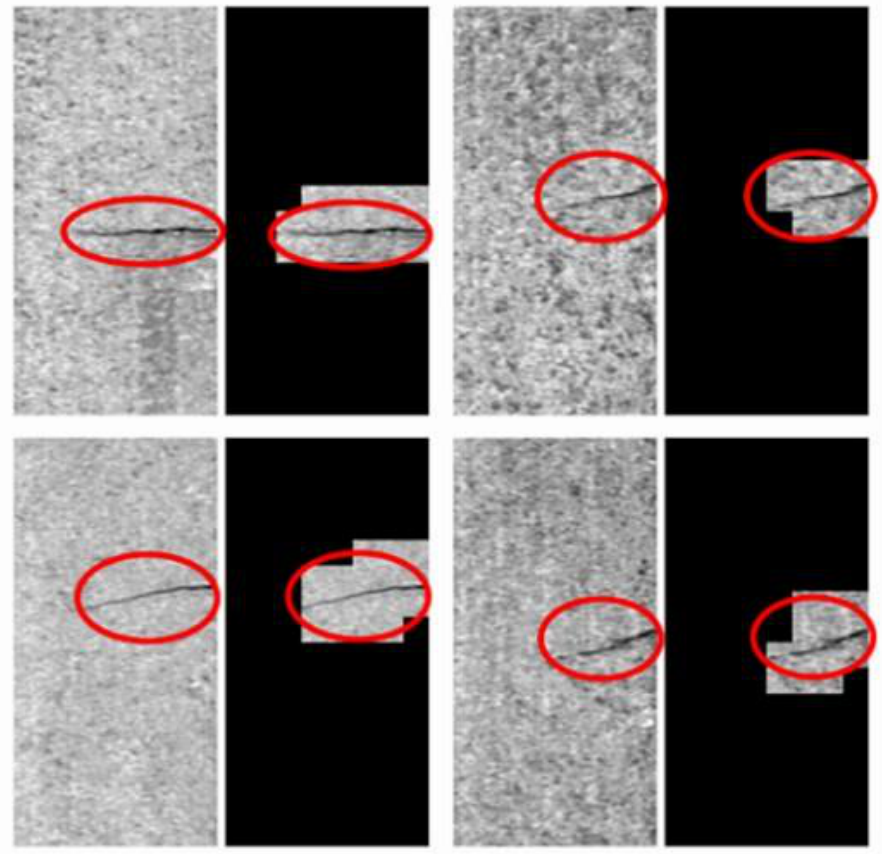
Figure 17. The examples of detection results in the KolektorSDD dataset. The red ellipse marks the location of the defect. The left image is the image to be detected, and the right image is the detection result. Our model judges that areas without defects are covered with black